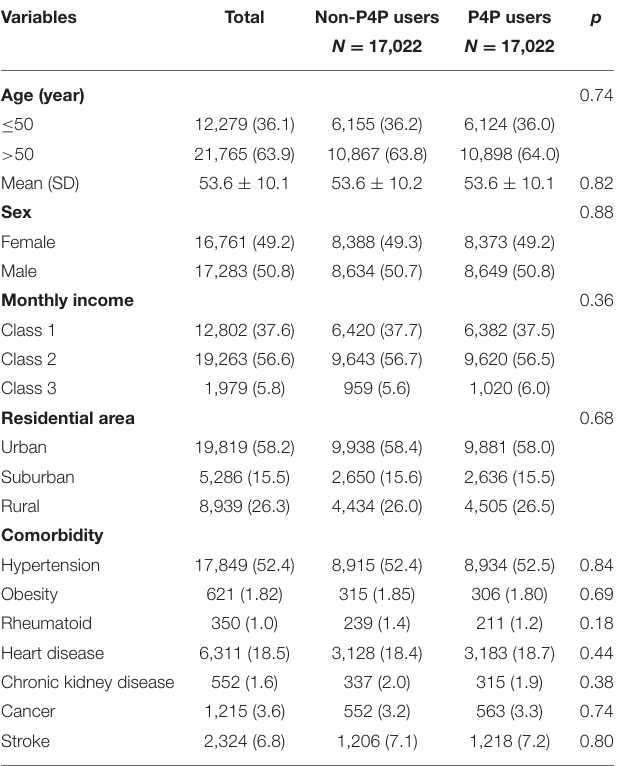
TABLE 1 | Demographic data and selected comorbidities of study